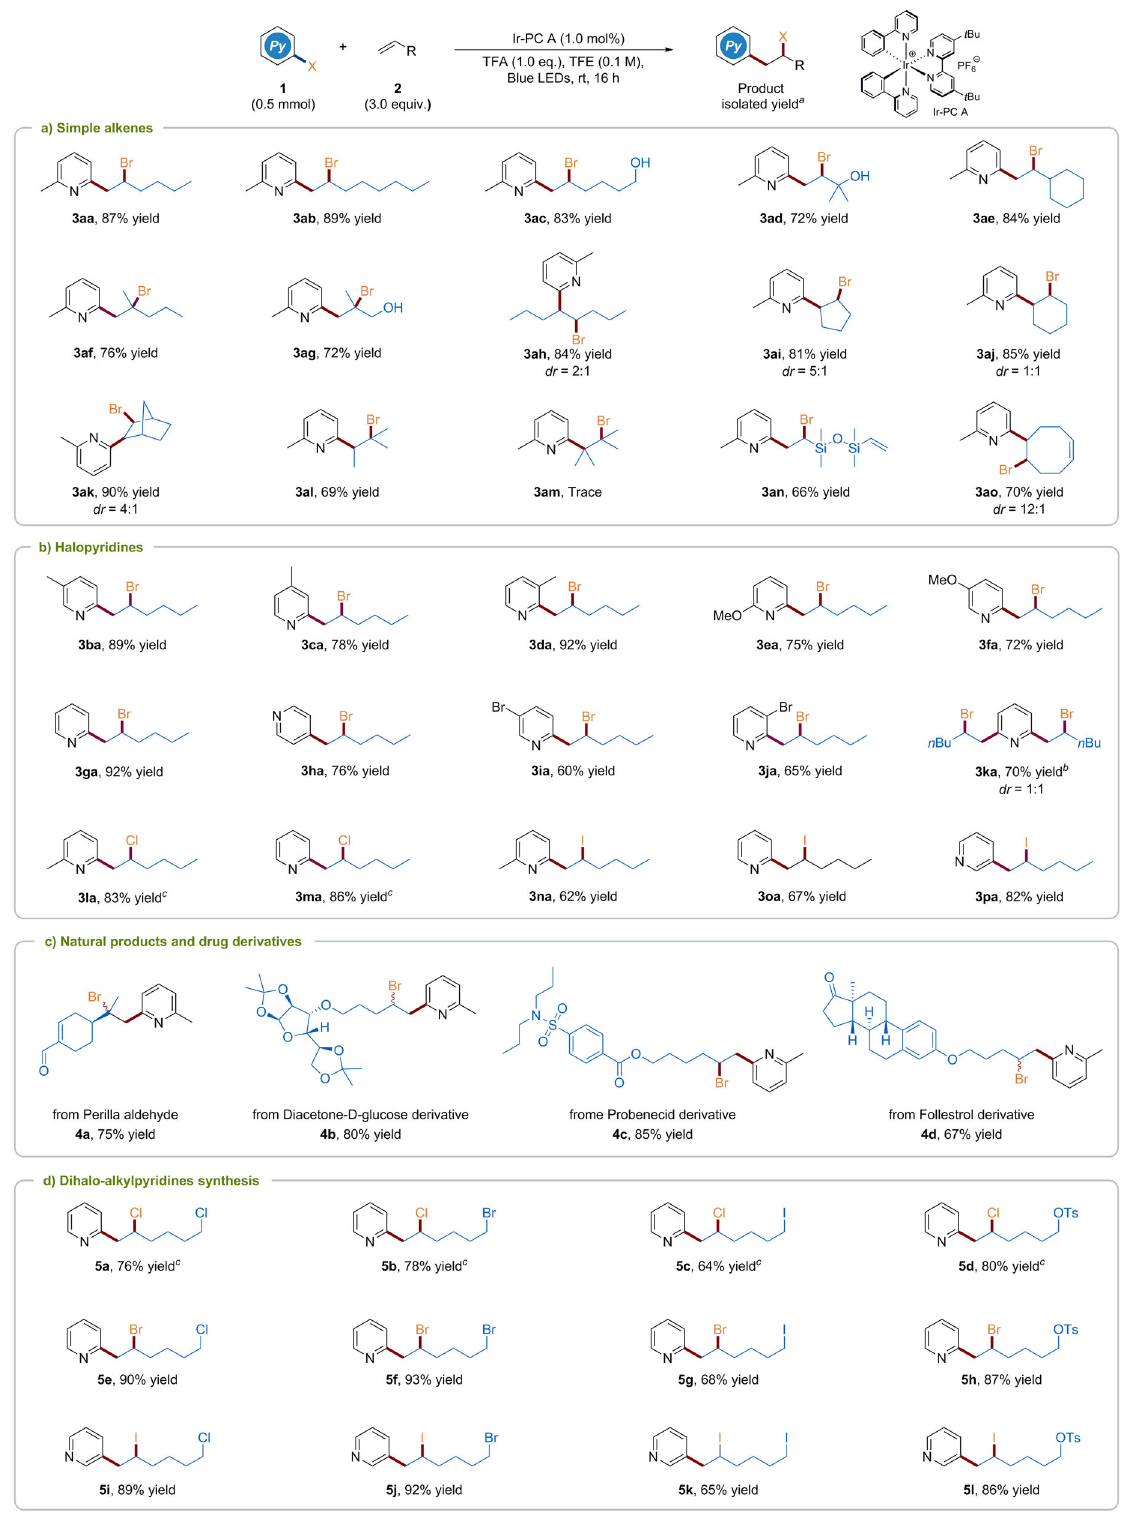
Fig. 2 Substrate scope. a Simple alkenes scope. b Halopyridines scope. c Natural products and drug derivatives. d Dihalo-alkylpyridines synthesis. a Yields of isolated products. Diastereoselectivity ( dr ) was determined by 1 H NMR analysis. b 4.0 equivalents of 2a was used. c 20 h. PC changed to EtOH, reduction potential of the 1a + TFA mixture fell Fig. 3d, a sharp reduction peak of 1a with E 1/2 red = − 0.76 V to E 1/2 red = − 0.95 V (vs. SCE) (Fig. 3e). These results suggest that (vs. SCE) was observed in the cathodic reduction scan in TFE, the halopyridine substrate is most likely protonated fi rst by and the 1a + TFA mixture (1:1 molar ratio) could rise to the Brønsted acid TFA and gets stronger oxidizing properties. E 1/2 red = -0.69 V (vs. SCE). Moreover, when the solvent was